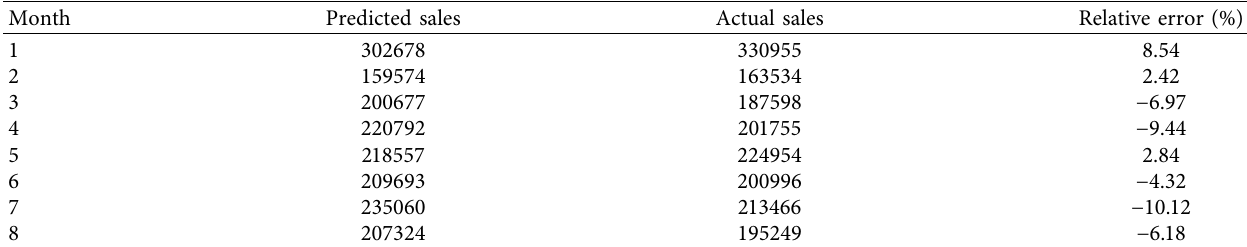
Figure 6: The curves of the sum of the square of the error for the BP neural network: (a) without GA optimization and (b) with GA optimization. Table 1: Comparison of sales forecast results and actual values based on BP neural